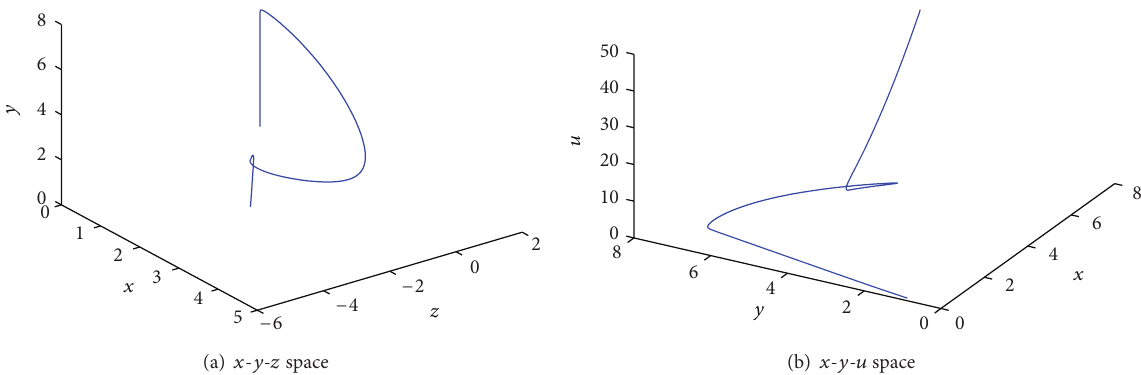
Figure 7: Phase portraits of system (3) for 𝑞 1 = 0.98 , 𝑞 2 = 0.4 , 𝑞 3 = 0.97 , 𝑞 4 = 0.78 , 𝑎 = 3 , 𝑏 = 0.3 , 𝑐 = 0.8 , and 𝑑 = 0.1 .